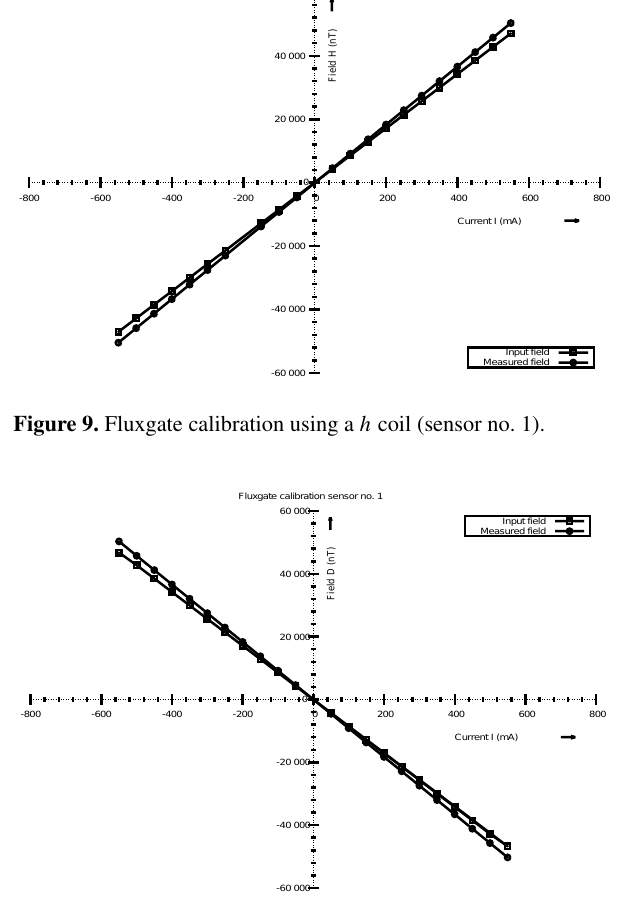
Figure 10. Fluxgate calibration using a d coil (sensor no.